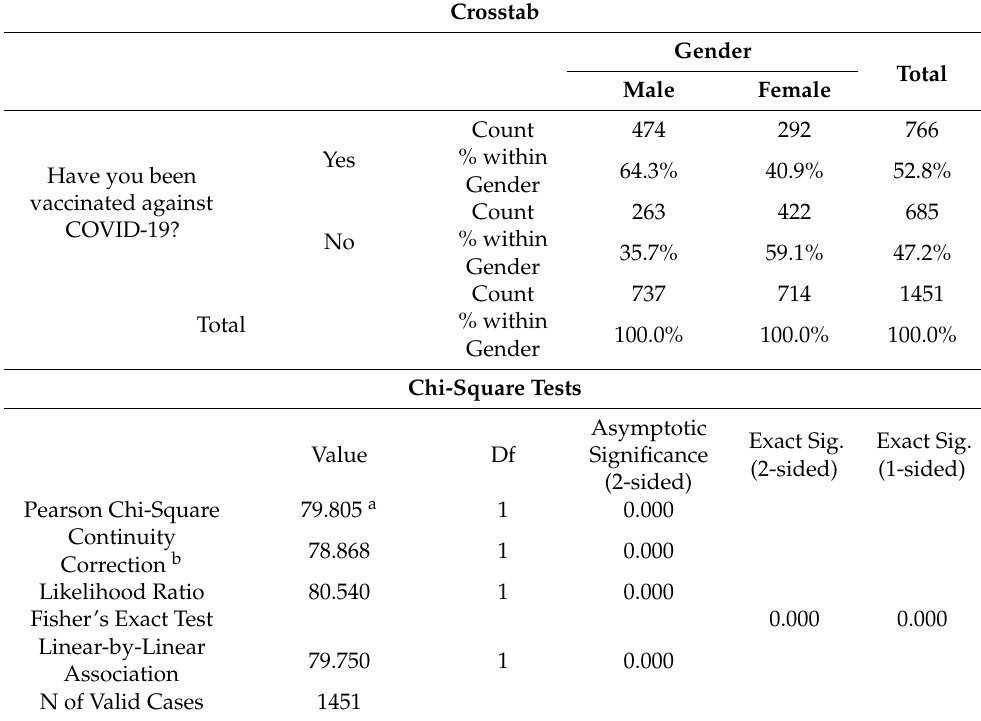
Table 7. Vaccination status as reported by respondents by